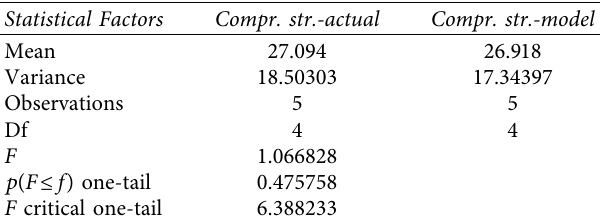
Table 27: F -Test two-sample for variances for compressive strength response.